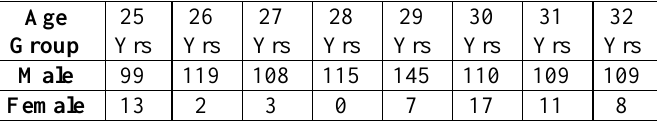
Table 6: Gender and age group involved in